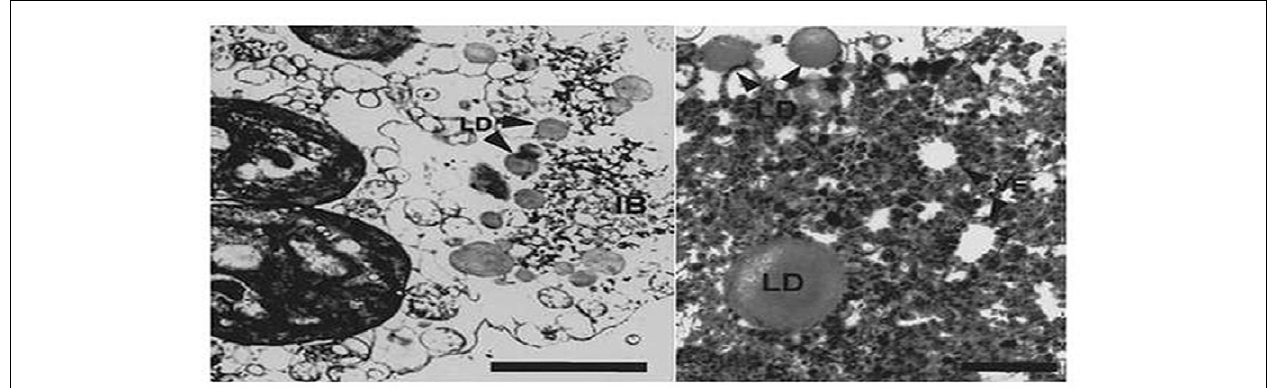
FIGURE 5 |Transmission electron microscopic (TEM) analysis shows lipid droplets (LD) that surround vesicles (VE) within the BYV-type inclusion bodies in LIYV RNA 1 and RNA2-infected N. benthamiana mesophyll protoplasts. Image from Medina etal., 1998 with permission.